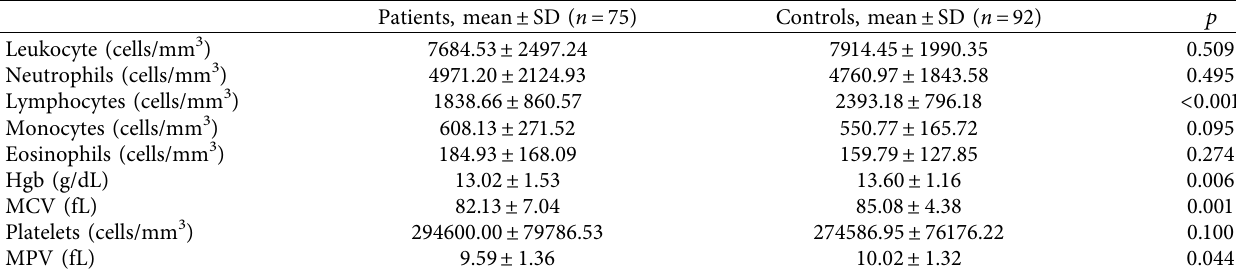
Table 2: The comparison of hematological parameters between the study and control groups. Patients, mean ± SD ( n � 75)